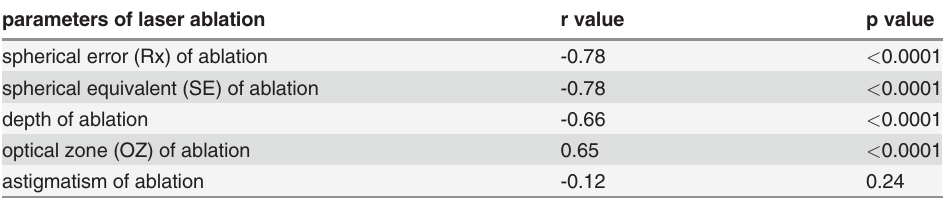
Table 3. Pearson correlation analyses between the measured area of wavefront aberration and the parameters of laser ablation.